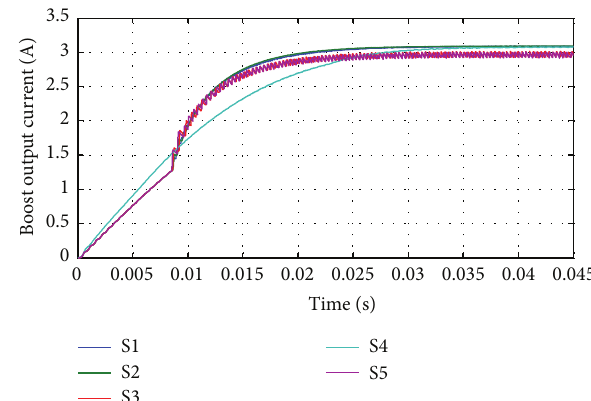
Figure 17: Boost output power at irradiation of 1000 W/m 2 and 25 ∘ C.